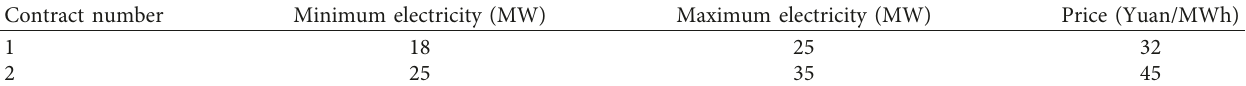
Table 3: The electricity contracts.